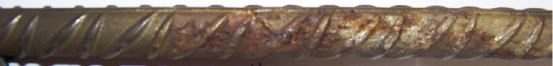
Figure 10. Localized corrosion mechanism: on site evidence on reinforced steel